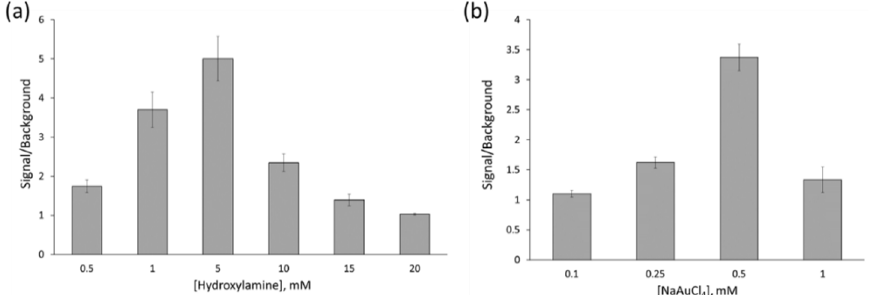
Figure 5. Au-amplified Mn-ZnS QD number measured (signal to background) after performing the PSA immunoassay using different amplification conditions, ( a ) hydroxylamine concentration (reducing agent) and ( b ) NaAuCl 4 concentration, while keeping constant the rest of parameters. Error bars correspond to 1SD.